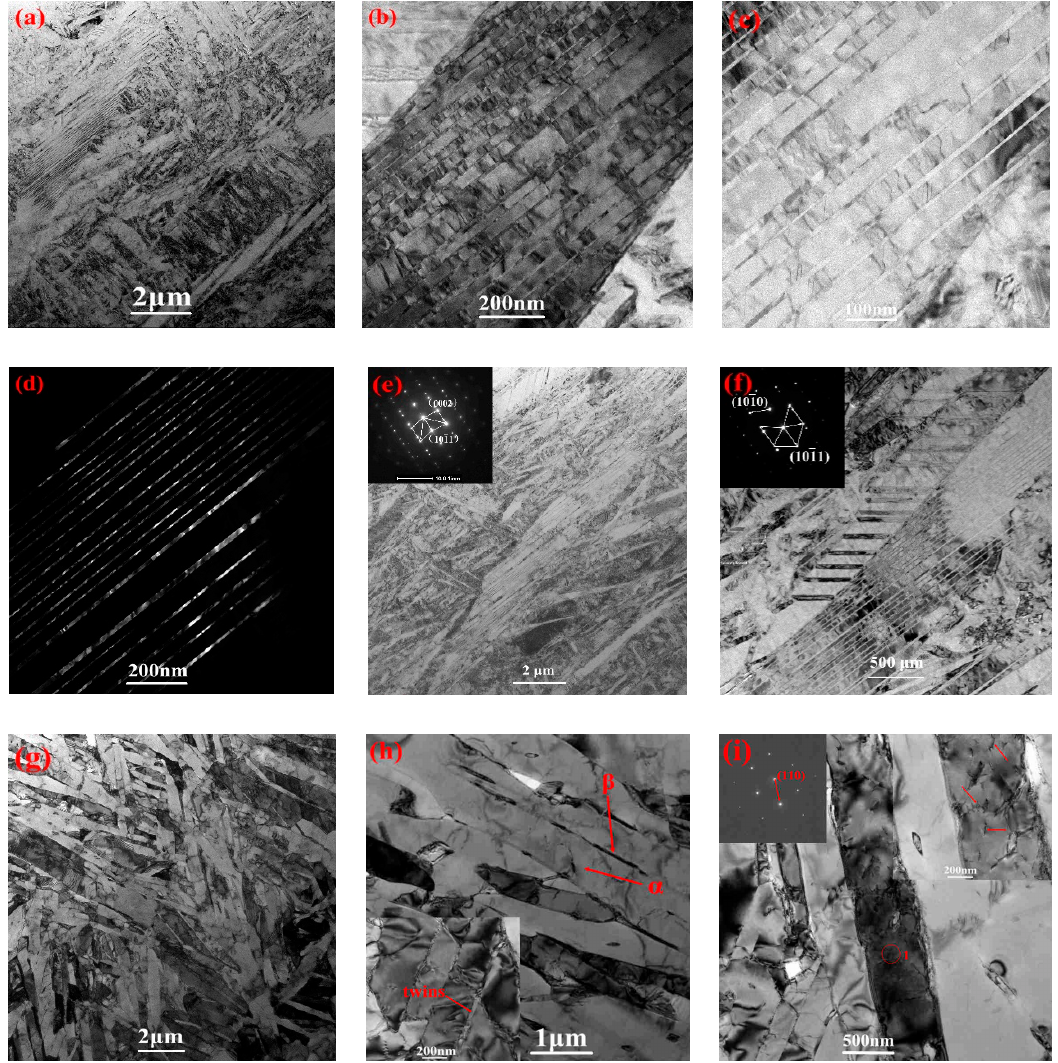
Figure 6. Transmission electron microscopy (TEM) of as-built cube samples: bright field ( a – c ); dark field ( d ); twinning and diffraction pattern ( e , f ) and stress relieving samples of bright field ( g – i ).